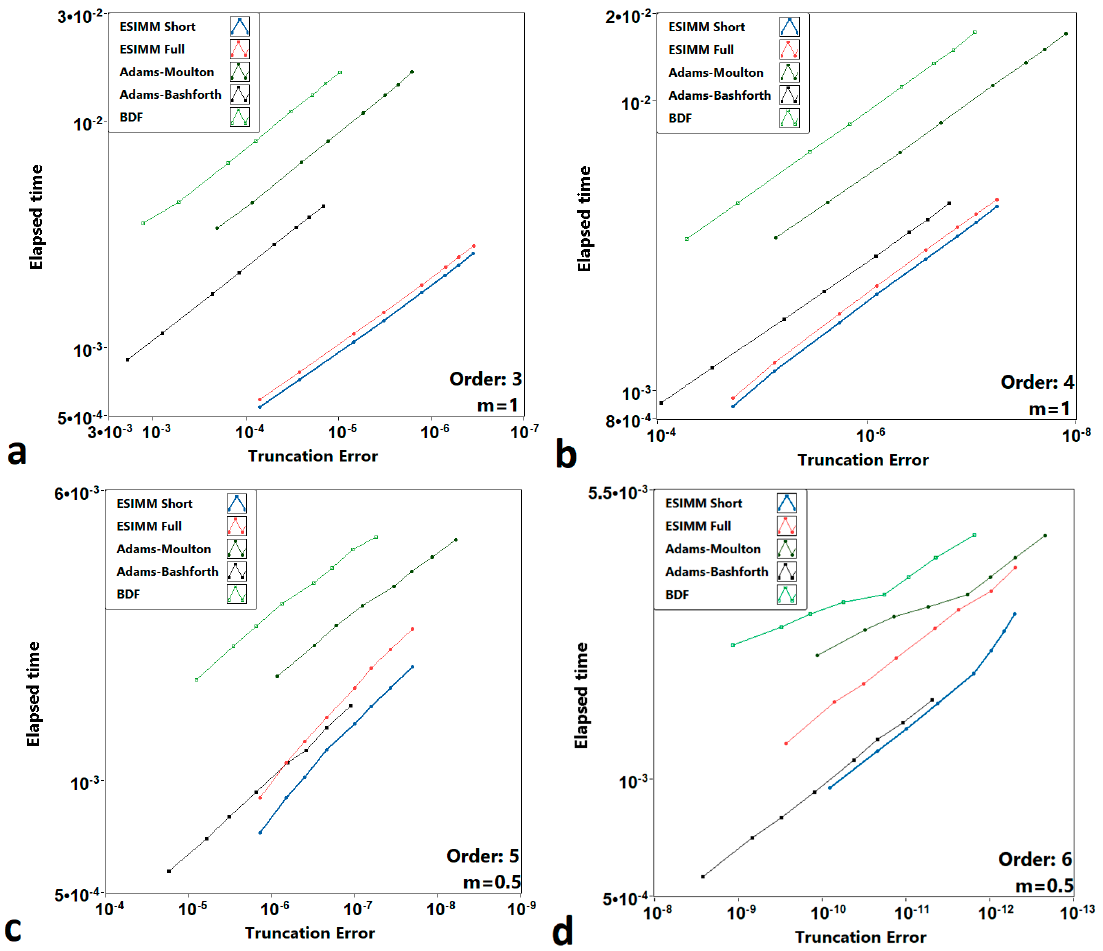
Figure 6. The performance plots of van der Pol system obtained for investigated multistep methods with the accuracy ( a ) order 3, ( b ) order 4, ( c ) order 5 and ( d ) order 6.